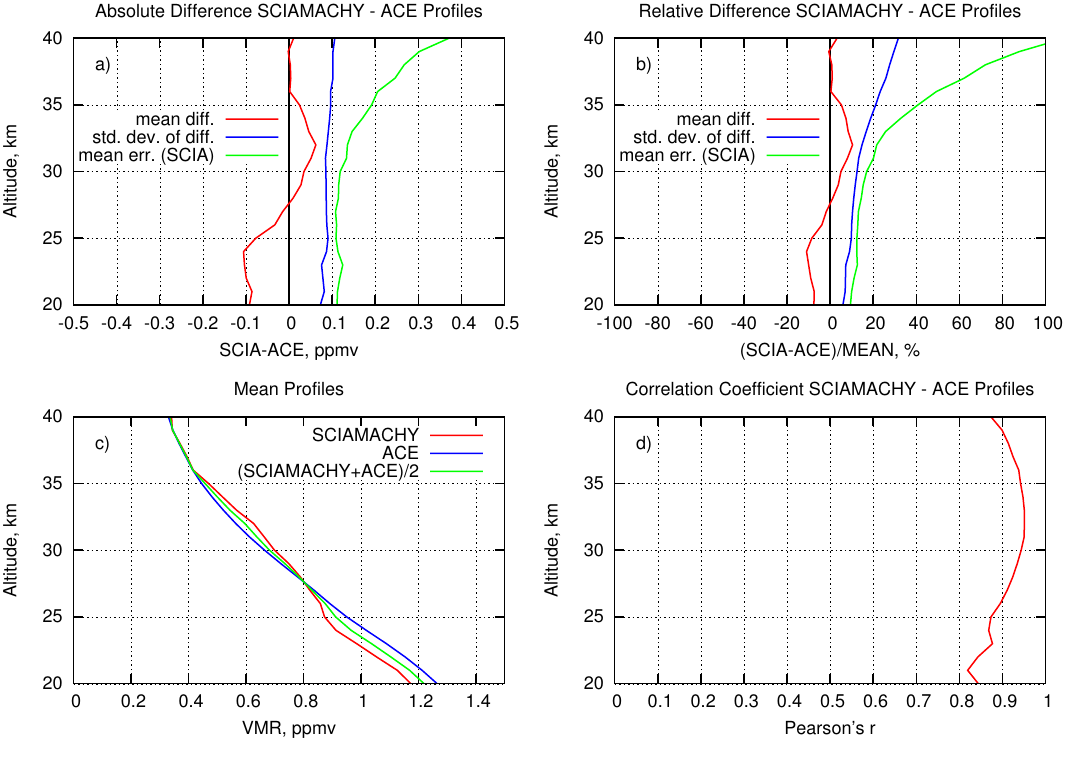
Fig. 3. Comparison of retrieved SCIAMACHY methane profiles (ONPD V3.3.6) with ACE-FTS data (V2.2). (a) Mean absolute difference (red) and its standard deviation (blue); mean absolute error of SCIAMACHY data (green). (b) Mean relative difference (red) and its standard deviation (blue); mean relative error of SCIAMACHY data (green). (c) Mean profiles (red: SCIAMACHY, blue: ACE-FTS, green: average of both). (d) Correlation between SCIAMACHY and ACE-FTS